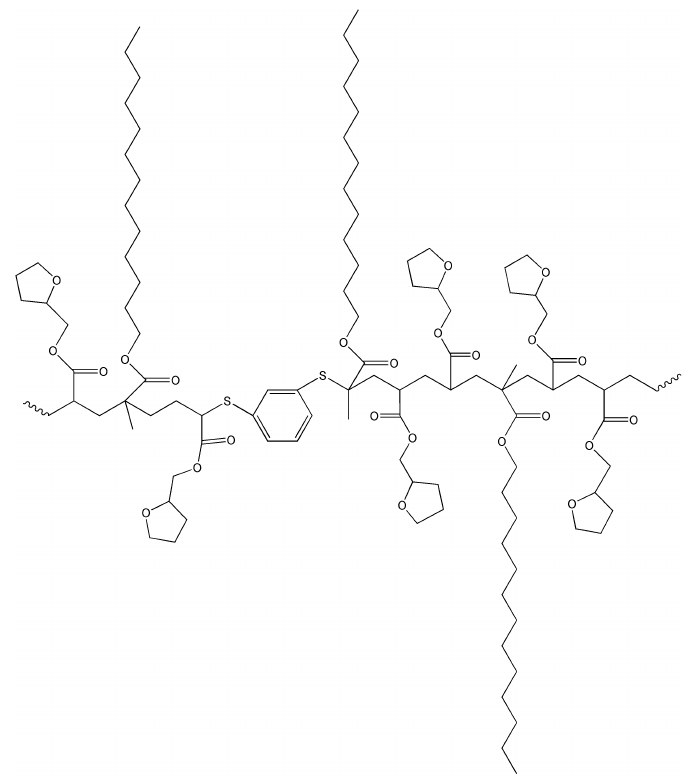
Figure 2. The possible polymer structure.